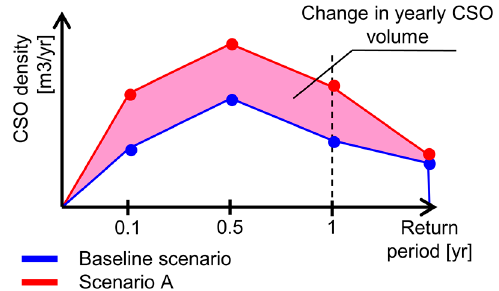
Figure 2. Illustration of method used to extrapolate annual statistics from discrete events with different return periods. The hatched area corresponds to the difference between two investigated scenarios.